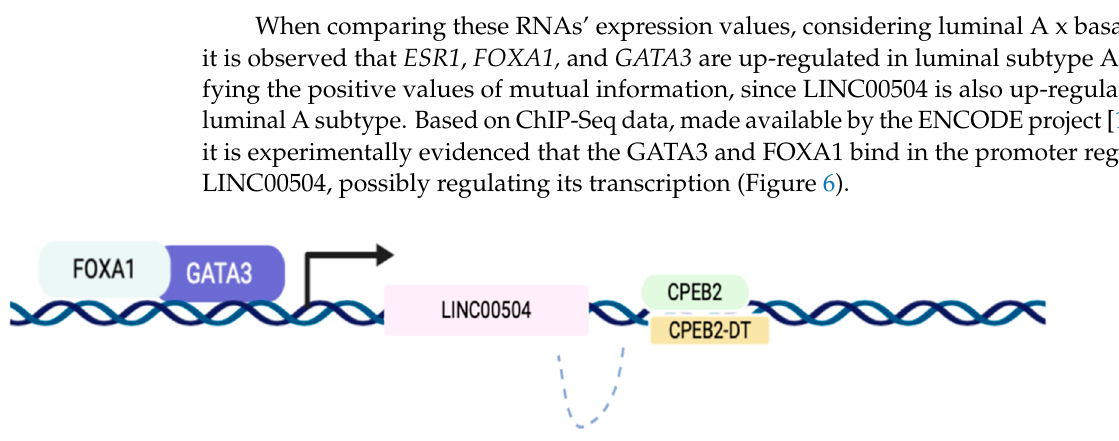
Table 1. LINC00504 co ‐ expression network elements detailing .